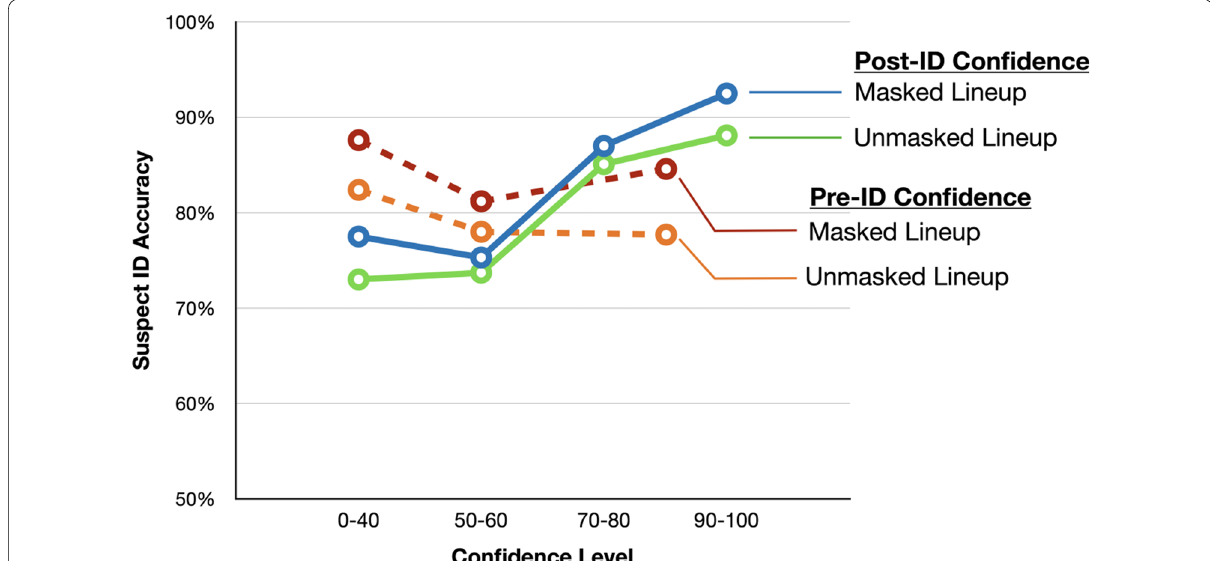
Fig. 4 Confidence-Accuracy Characteristics (CAC) curves for the masked and unmasked lineups in Experiment 2. The solid curves are based on post-ID confidence (like those in Experiment 1) and the dotted curves are based on pre-ID confidence (applicable to only Experiment 2). The pre-ID confidence data were binned into confidence levels from 0–40, 50–60, and 70–100. The y-axis starts at 50%. Note that the values that contribute to a CAC curve are proportions from the whole sample and so CAC curves do not have error bars